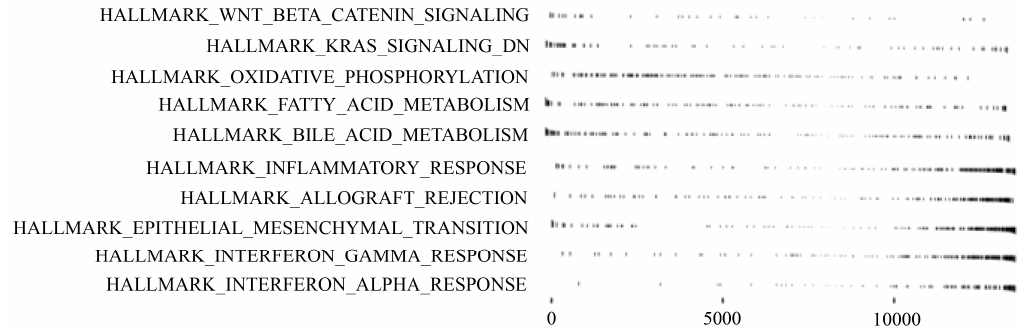
Figure 3. Subtype-specific signaling pathways obtained from GSEA. The left represents pathway names, and the right represents gene ranks. Table 6. Summary of KEGG pathway, miRNA, and GO